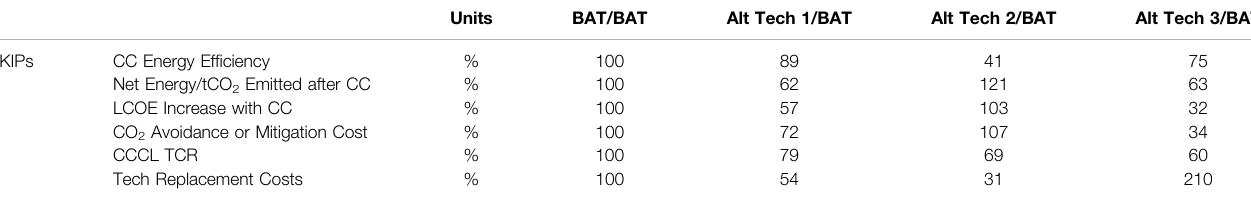
TABLE 5 | Relative comparisons of three Alt Techs of this study to BAT using Eq. 1 for the selected KIPs from Table 4